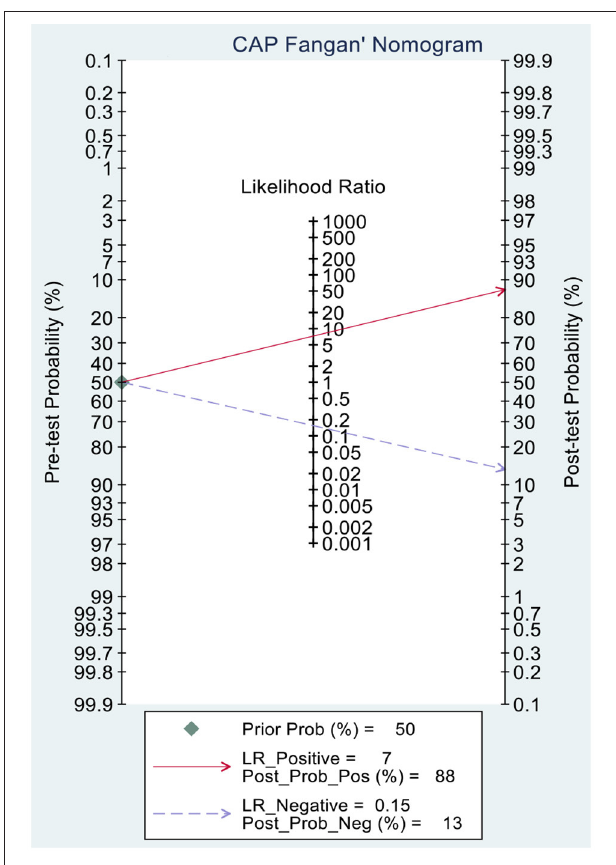
FIGURE 5 | Fagan plot analysis to evaluate the clinical utility of MRI-PDFF and TE-CAP (S0 vs. S1–S3).